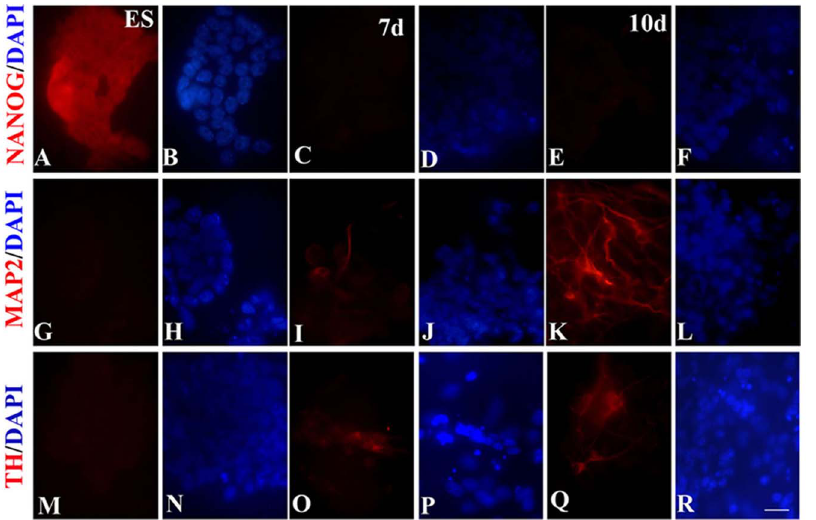
Figure 3. Immunocytochemical localization of stem cells, neuronal and dopaminergic markers. Immunostaining for pluripotency marker, NANOG for ES (A), 7 d (C) and 10 d (E), co-stained for nuclei with 4,6-diamidino-2-phenylindole (DAPI) (B,D,F). Microtubule associated protein (MAP2) is used for showing the presence of neurons in ES (G), 7 d (I) and 10 d (K), co-stained with DAPI (H,J,L). To see if dopaminergic neurons are present, the ES (M), 7 d (O) and 10 d (Q) cells were stained for tyrosine hydroxylase (TH), a rate limiting enzyme for dopamine synthesis. DAPI was used for staining nuclei (N,P,R). Nuclear stain, DAPI showed the total number of cells for each field. Scale bar 20 m m. All the other abbreviations are as in Figure 1 legends.